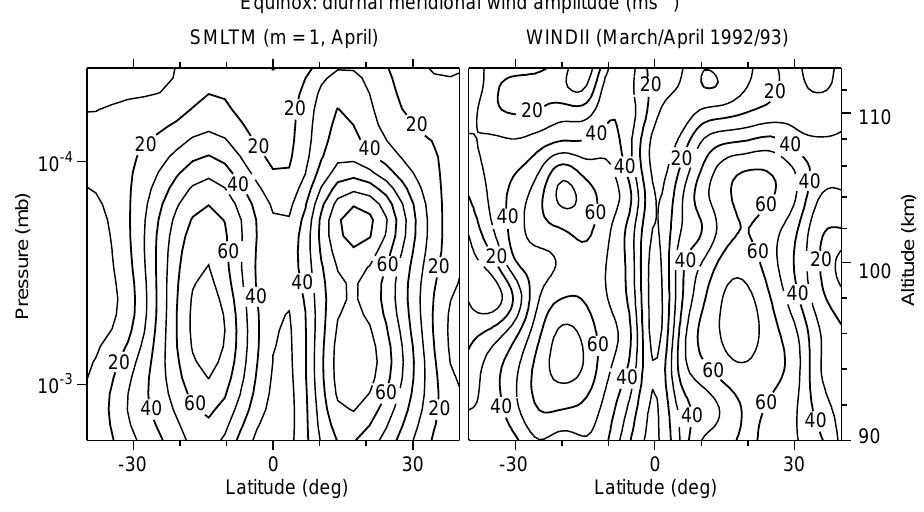
Fig. 1. Diurnal tidal amplitude for meridional wind (contour interval 10m s (cid:255) 1 ): SMLTM simulations (cid:133) m (cid:136) 1 (cid:134) for April ( left panel ); WINDII diurnal tidal amplitude (McLandress et al ., 1996) for March/April 1992/93 ( right